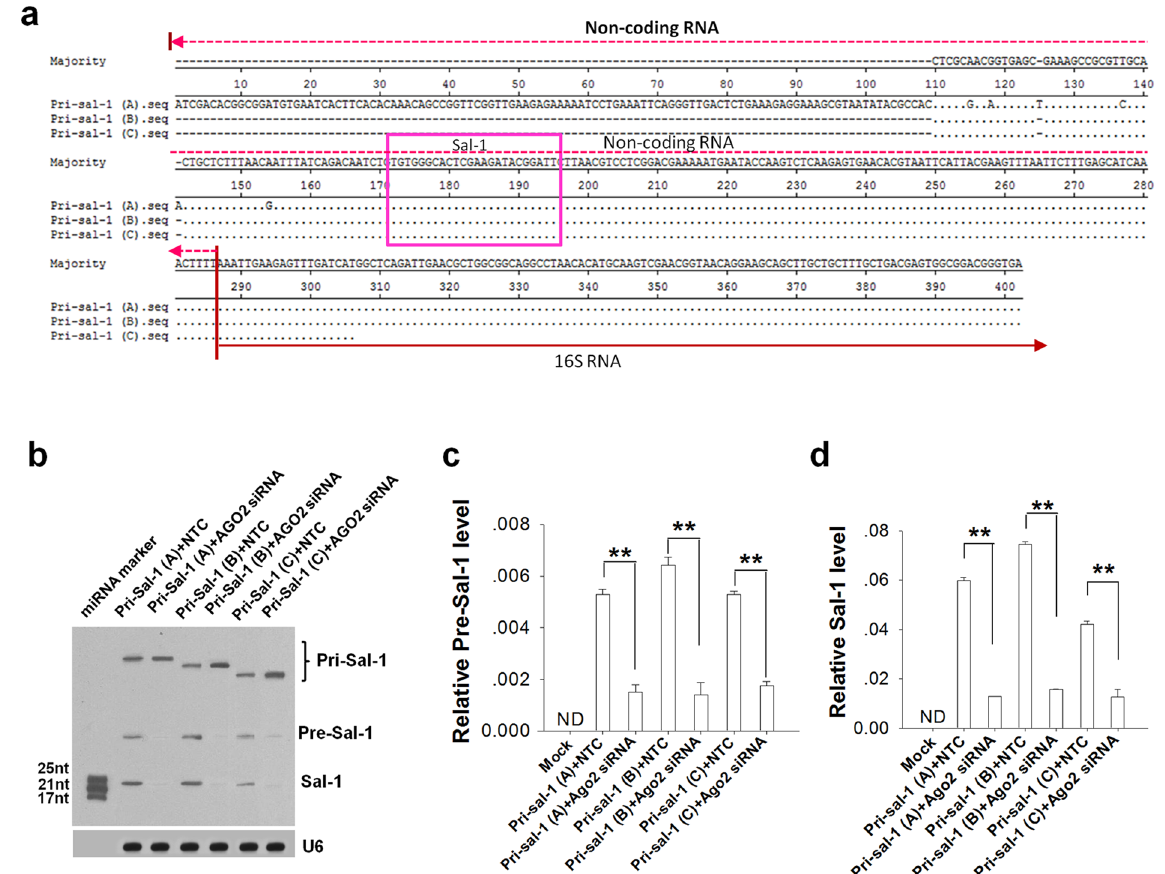
Figure 4. Identification of ‘primary’ form of Sal-1 in SE2472-infected HT-29 cells, which can be processed into pre-Sal-1 and mature Sal-1 sequentially. ( a ) Analysis of the sequences of three primary Sal-1 sites consisting of non-coding RNA and a partial region of the 5 ′ terminus of the 16 sRNA. ( b ) AGO2-dependent of Sal-1 generation from 3 possible Pri-Sal-1 (A, B and C) in HT-29 cells. Pri-Sal-1 (A, B and C) were amplified from infected HT-29 cells with 3 ′ - and 5 ′ - RT-RACE cDNA amplification followed by insertion into a pGEM-11Zf( + ) vector for in vitro transcription. These primary Sal-1 RNA transcription fragments were then transfected into HT-29 for pre-Sal-1 and Sal-1 production. ( c - d ) Levels of pre-Sal-1 ( c ) and Sal-1 ( d ) in the pri-Sal-1-transfected HT-29 cells with or without silencing Ago2 . The data are presented as the mean ± SEM (n = 3). ** P < 0.01. ND, not